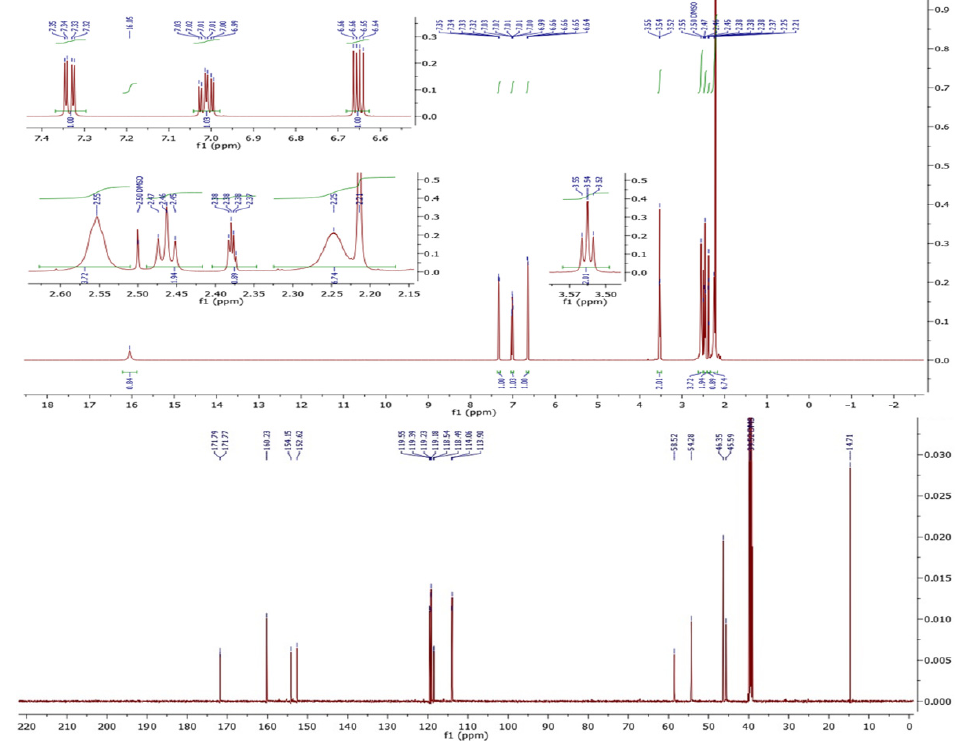
Figure 1. 1 H- and 13 C-NMR of the SB-functionalized ligand in DMSO- d 6 . The measured FT-IR transmissions of starting materials, tetradentate ligand and